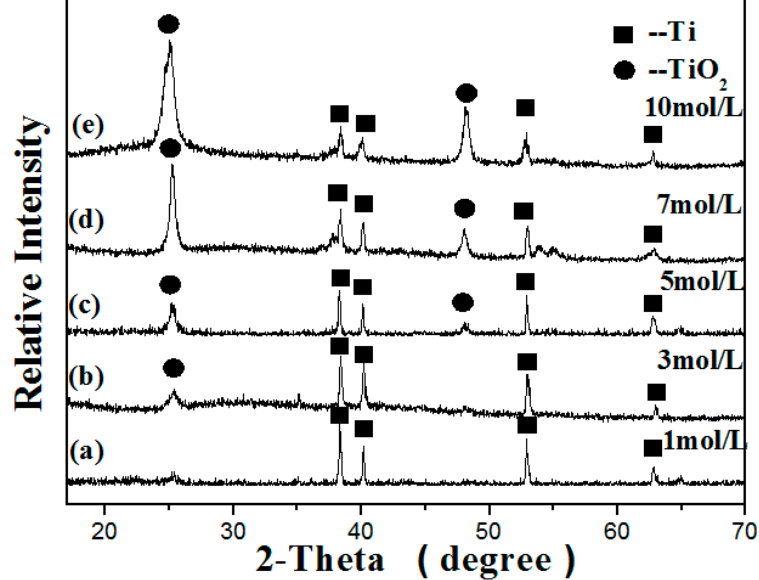
Figure 3. XRD patterns of samples prepared at the different concentration of NaOH. (a) 1 mol/L; (b) 3 mol/L; (c) 5 mol/L; (d) 7 mol/L; (e) 10 mol/L.